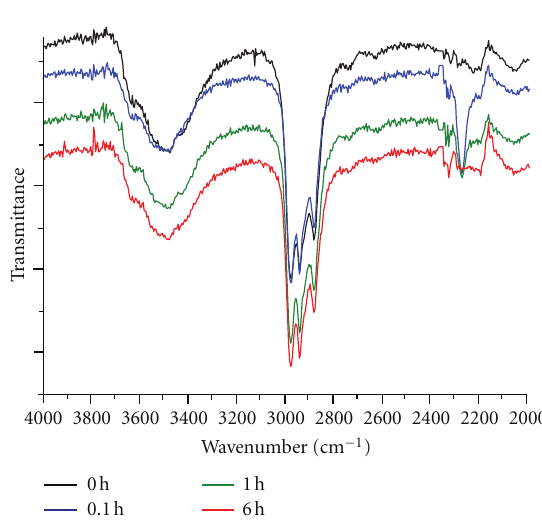
F 2: IR spectra of the polymer solution during reaction of free hydroxyls on the polymer with ICPTES for different reaction times, showing the disappearance of isocyanate